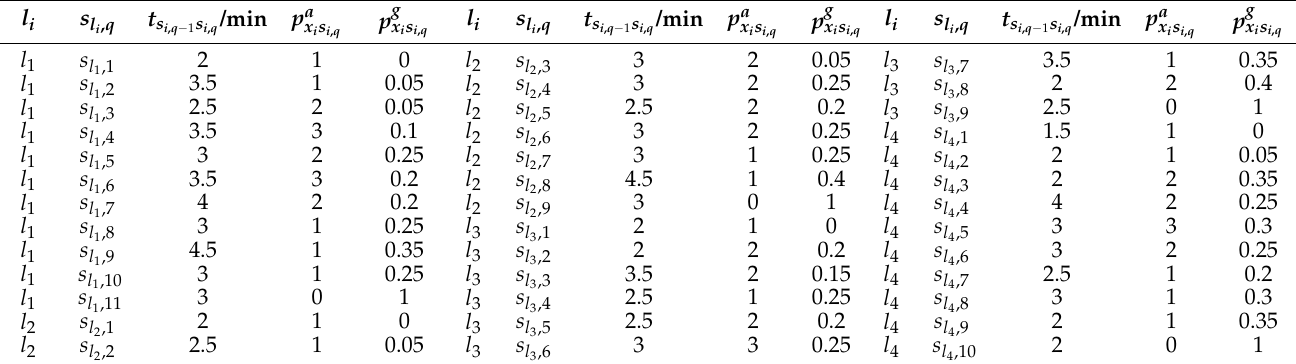
Table 2. The average arrival rate, alighting rate of passengers and travel time between stations.